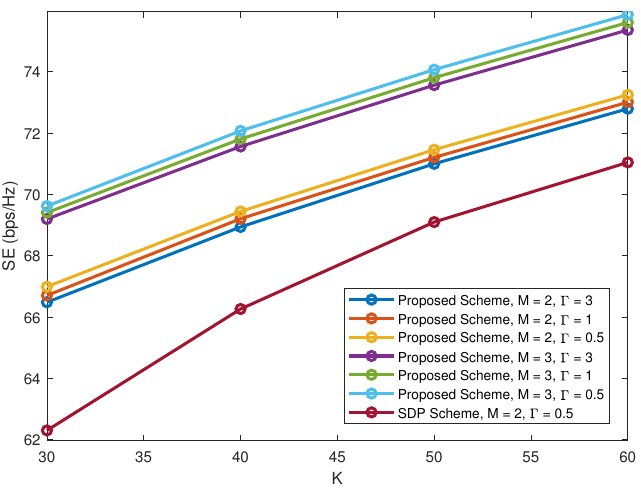
Proposed Scheme, M = 2, = 3 Proposed Scheme, M = 2, = 1 Proposed Scheme, M = 2, = 0.5 Proposed Scheme, M = 3, = 3 Proposed Scheme, M = 3, = 1 Proposed Scheme, M = 3, = 0.5